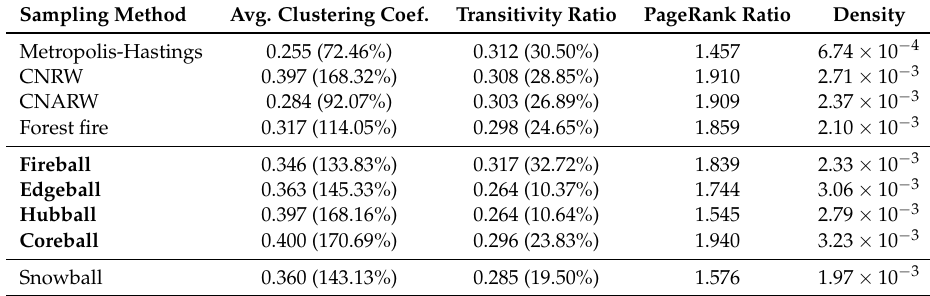
Table 5. Numerical results for the Google+ graph sampled at 10%. Full graph’s average clustering coefficient is 0.148, transitivity ratio is 0.238, density is 5.57 × 10 − 5 . Relative error for the average clustering coefficient and transitivity ratio is shown between parentheses.